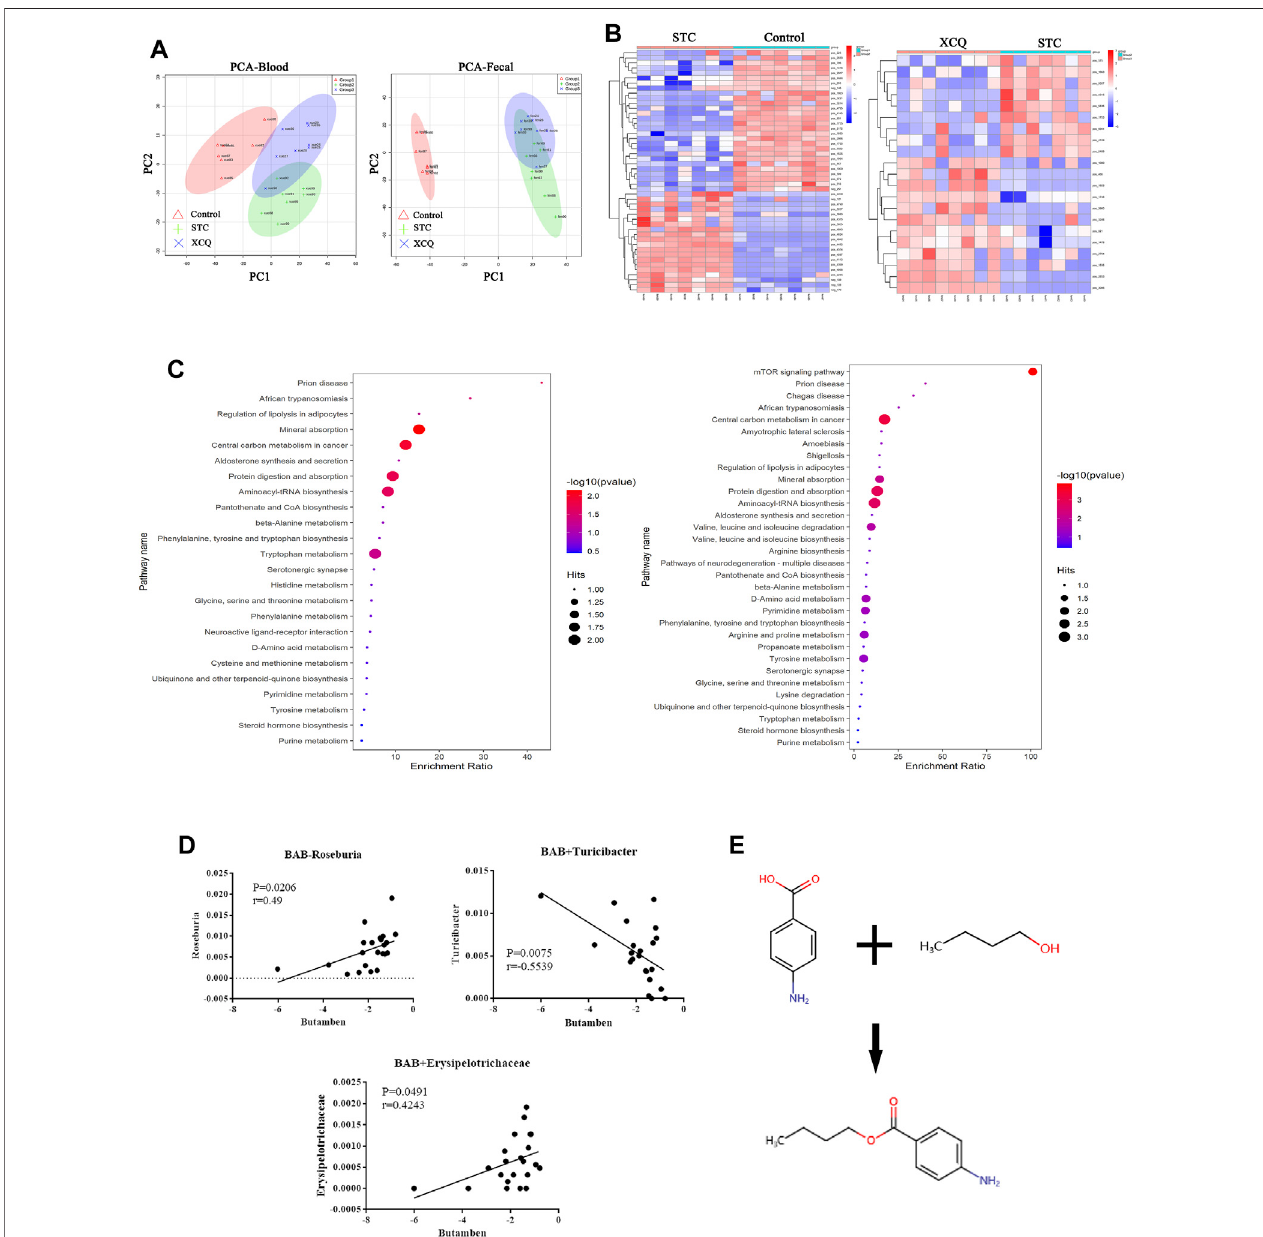
FIGURE4| TheeffectoftheXiaoChengqi(XCQ)formulaonmetabolitesinslowtransitconstipation(STC)rats. (A) PCAanalysisofcomponentdifferencesbetween groupsshowedthatthemetabolitesinfeces(left)andserum(right)ofSTCratsweresigni fi cantlydifferentfromthoseinthecontrolgroup,andtheuseoftheXCQformula could signi fi cantly affect the metabolism of STC rats; (B) from the metabolite heat map (left is the control group and STC group, right is the STC group and experimental group), it can be seen that the contents of n-methyltyramine, butyl aminophenyl and 5-deoxy-5-methylthioadenosine were signi fi cantly different among the three groups; (C) TheKEGGenrichmentanalysisshowedasbubblechartbetweeneachtwogroups; (D) TherelationshipbetweenBABandtheabundanceof Roseburia spp . (Pearson correlation = 0.501); (E) The compound structure of BAB.